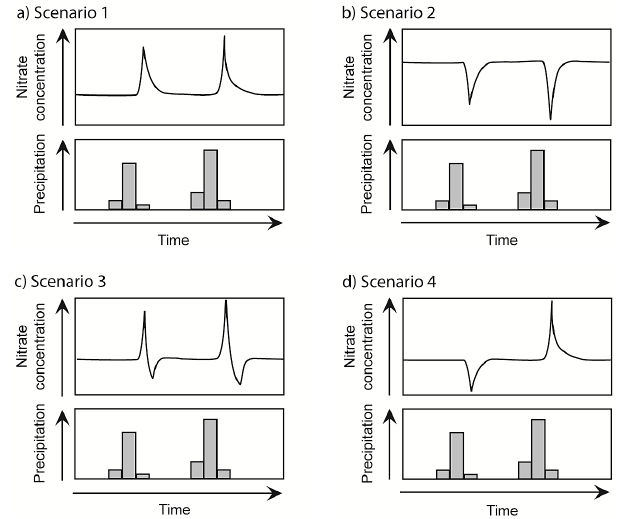
Figure 5. Hypothesis of nitrate response scenarios: predominance of (a) mobilised nitrate; (b) diluted nitrate; (c) mobilisation and di- lution during one event; (d) mobilisation and dilution during multi- ple rainfall